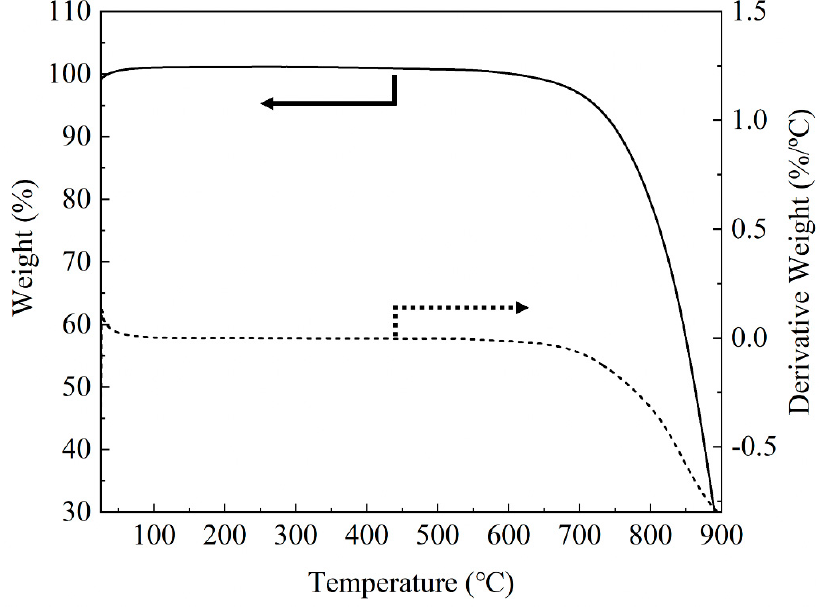
Figure 2. TGA/DTG curves of pristine GF.